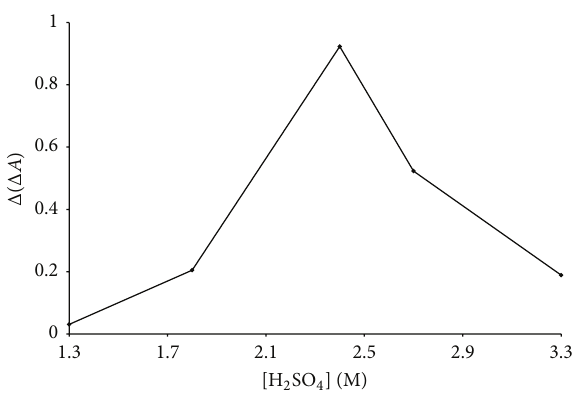
Figure 5: Effect of IO 4− on the sensitivity. Conditions: H 2 SO 4 , 2.4 molL −1 ; SCG; 12ngmL −1 ; TBAB, 1.1 × 10 −3 M; amaranth, 1.4 × 10 −4 M; temperature, 25 ∘